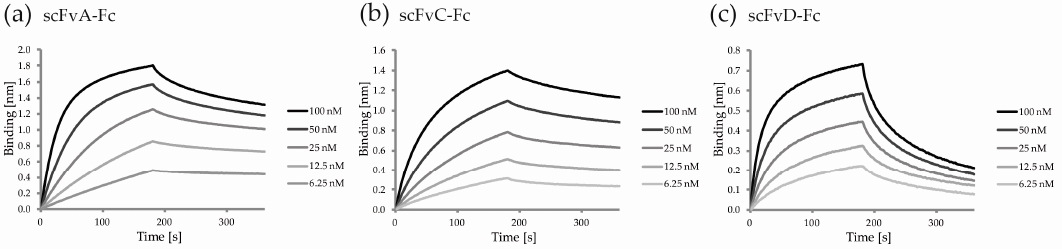
Figure 8. Sensograms for binding of serial two-fold dilutions of scFvs-Fc to FGF1. ( a – c ) Chemically immobilized FGF1 was used to capture analyzed scFvs-Fc, and the dissociation was measured in KB buffer. Table 2. Kinetic constants of the anti-FGF1 scFvs-Fc.